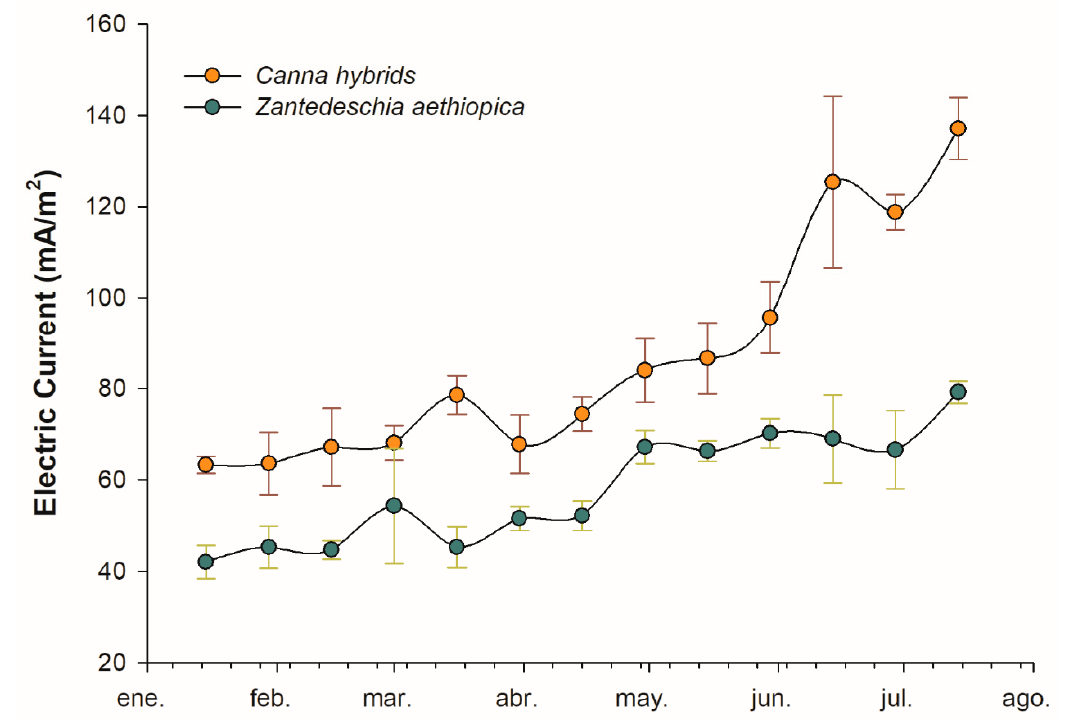
Figure 6. Comparison of the current (mA/m 2 ) generated in the VPS-CW systems using Canna hybrids and Z. aethiopica during 8 months of retention.